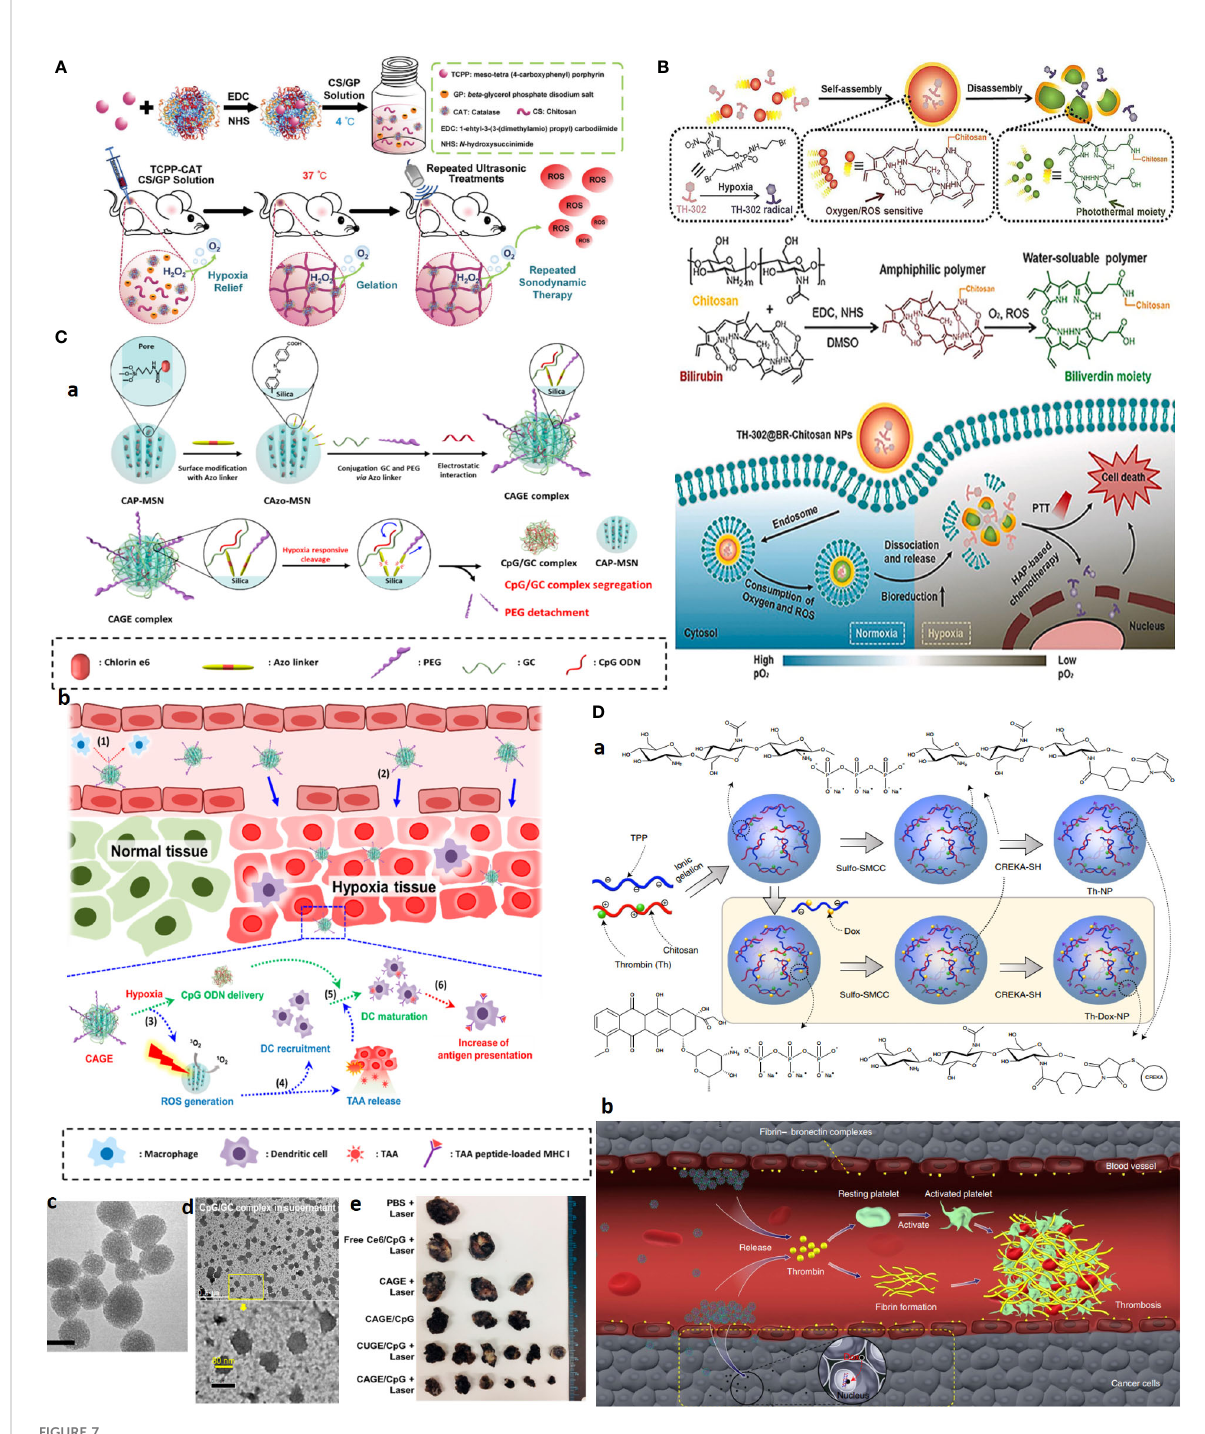
FIGURE 7 Advanced chitosan-based NPS target tumor hypoxia and result in complete tumor remission. (A) Hypoxia alleviation strategy. Schematics of thermo-triggered in situ chitosan gel formation for repeated and enhanced SDT after a single injection. Reprinted with permission from (100), Copyright (2020) Wiley ‐ VCH GmbH. (B) Hypoxia depletion therapy coupled with hypoxia-activated prodrugs (HAPs). Reprinted with permission from (109), Copyright (2021) Elsevier. (C) Hypoxia-responsive immunomodulation of DCs for boosted PDT coupled immunotherapy. (a) Schematic design of NPs, (b) working principle. (c, d) TEM images of CAGE without and with CpG ODN. (e) The ef fi cacy of antitumor effects in vivo . Reprinted with permission from (110), Copyright (2019) American Chemical Society. (D) Combination of tumor infarction therapy with chemotherapy for tumor starvation therapy. (a) Schematic design of NPs and (b) their working principle. Reprinted with permission from (111), Copyright (2021) Springer